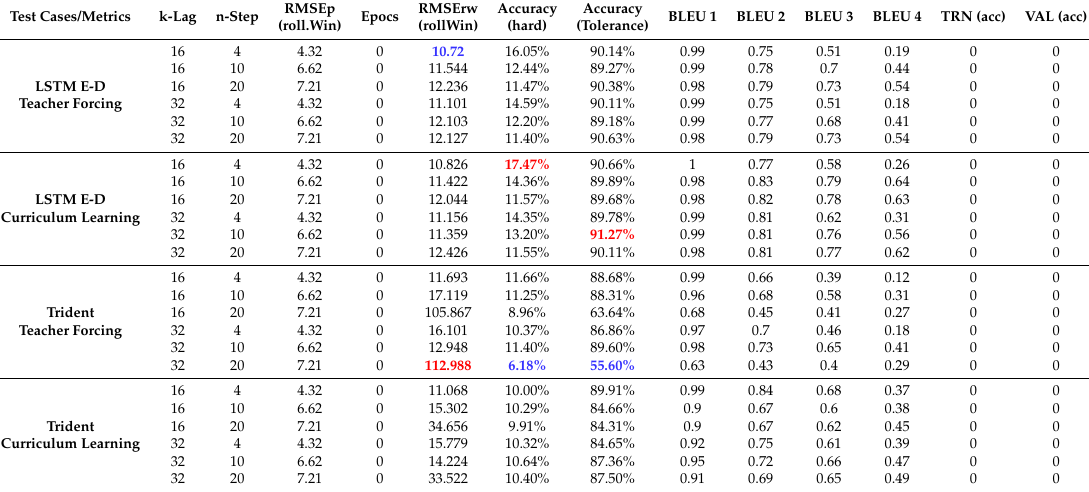
Table 4. Seq2Seq Encoder-Decoder Model Out-of-Sample Test Data Set Performance